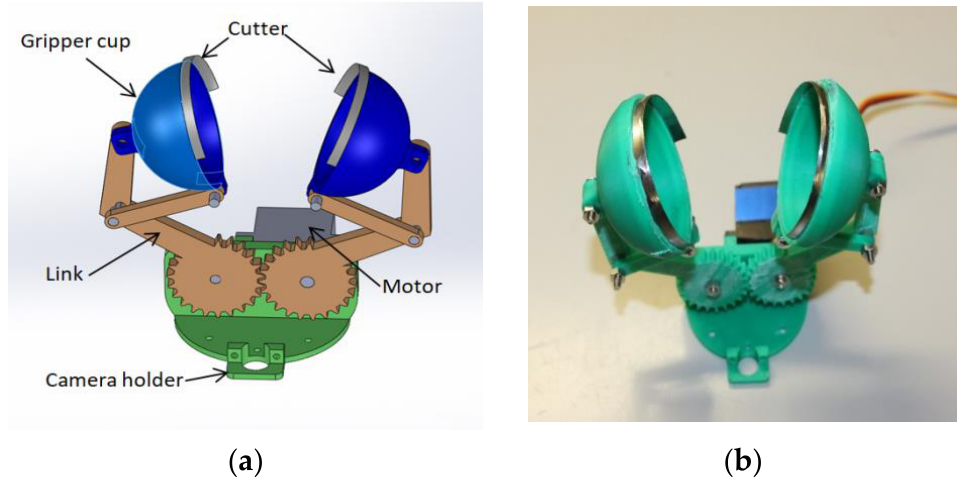
Figure 5. ( a ) Gripper CAD design and ( b ) Fabricated prototype.